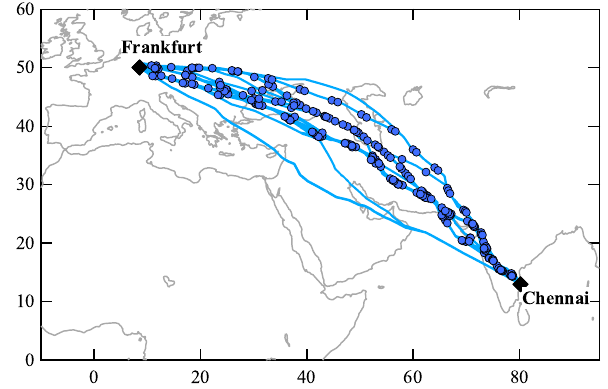
Fig. 1. CARIBIC flight routes between Frankfurt, Germany (FRA) and Chennai, India (MAA). Solid lines show the flight paths and filled circles indicate locations of whole air sample collection. The monsoon region is located south of 40 ◦ N, and only those samples collected south of this are considered here (Schuck et al.,